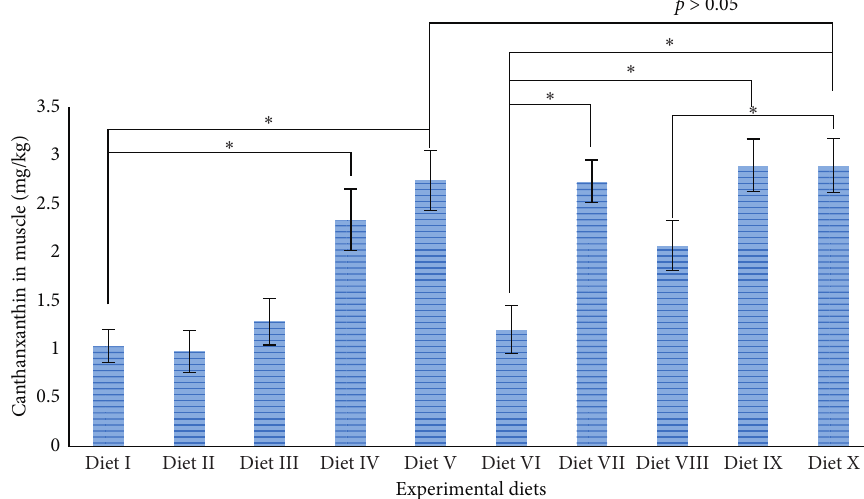
Figure 7: Canthaxanthin concentrations in muscle